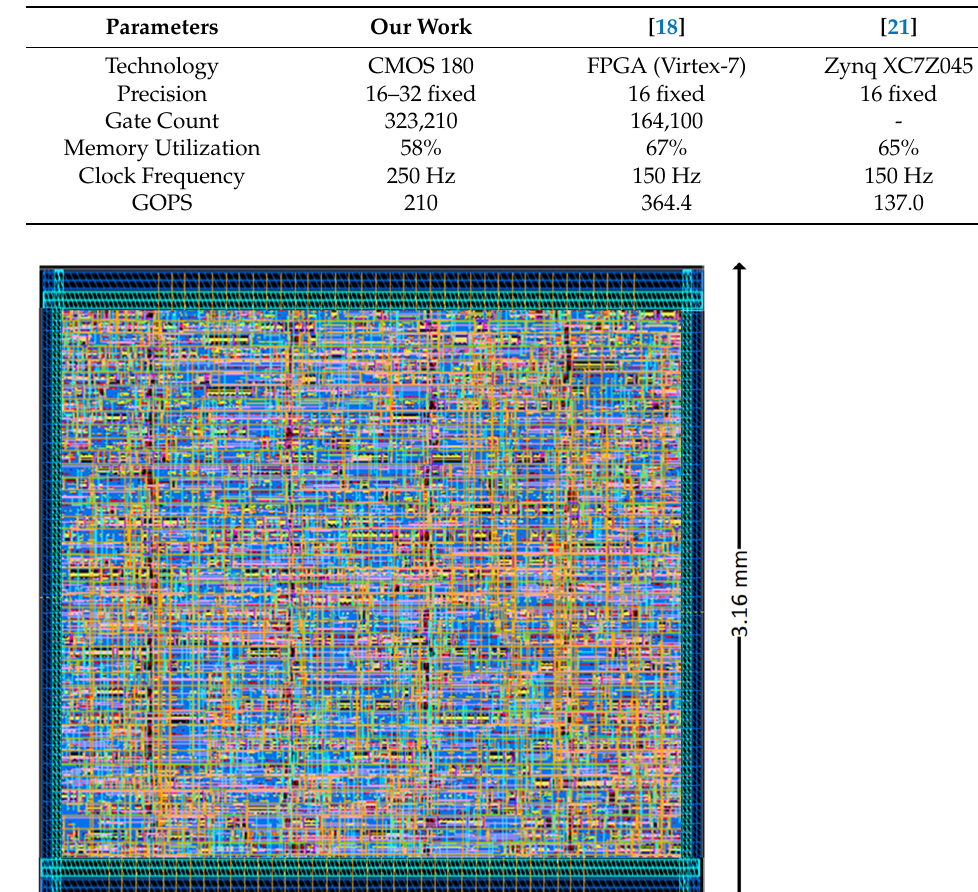
Table 2. Performance comparison with related works.